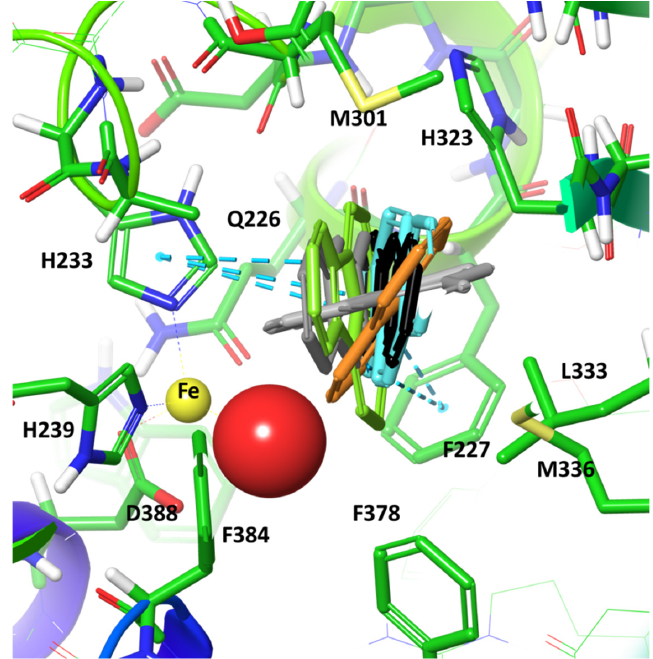
Figure 4. Molecular docking of naphthalene (orange), anthracene (black), fluoranthene (green), pyrene (gray), and chrysene (cyan) in catalytic pocket of dioxygenase from Paraburkholderia xenovorans LB400 (ID 2xsh), with docking scores of − 5.9, − 8.3, − 6.5, − 7.9, and − 8.4, respectively. Red ball represents oxygen molecule, and Fe ion interacts with His233, Asp388, and His239. Rhodococcus wratislaviensis IFP 2016 and Rhodococcus aetherivorans IFP 2017 were able to degrade 15 petroleum compounds (low-molecular-weight PAHs or aliphatic com- pounds: xylene, toluene, octane, and so on) (Table S2) [27]. The molecular docking of 10 PAHs into biphenyl dioxygenase from Rhodococcus jostii RHA1 (PDB ID 1ulj) revealed that only naphthalene and anthracene could be accommodated in the binding site, with good docking scores of − 6.7 and − 7.3 kcal/mol, respectively (Table S3) (Figure 5), alt-